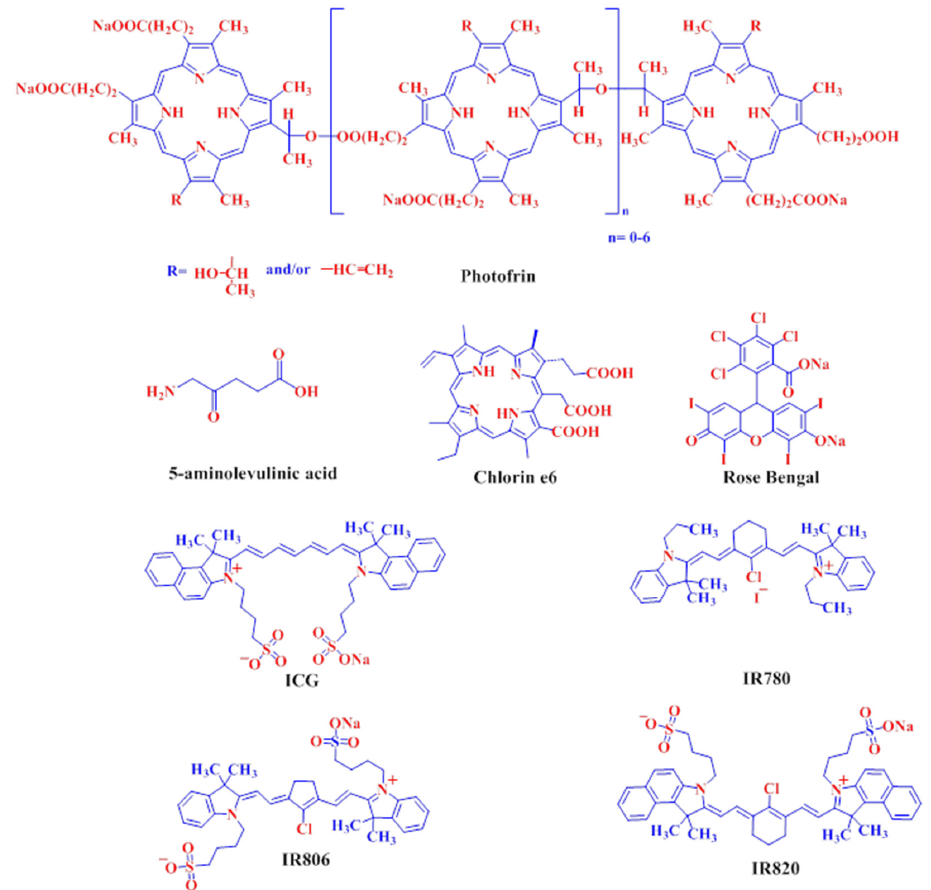
Figure 2. The chemical structure of ultraviolet-visible (UV-Vis) photosensitizers (top row) and near infrared (NIR) photosensitizers (bottom row).